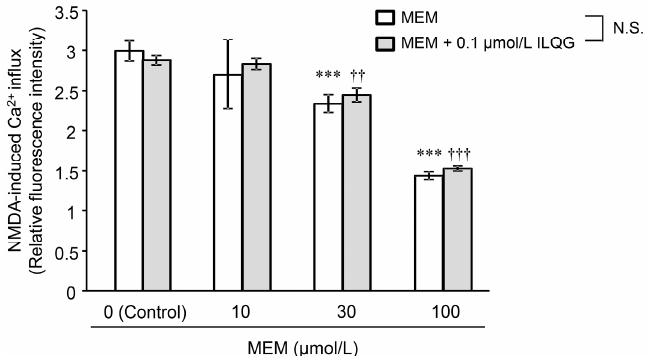
Figure 3. Inhibitory effects of MEM, isoliquiritigenin (ILQG), and their combination on NMDA-induced Ca 2+ influx in primary cultured neurons. A 3-min, NMDA-induced Ca 2+ influx reaction was started by adding recording buffer containing NMDA (final concentration of 300 µ mol/L) or NNDA + test substance (final concentration of 10–100 µ mol/L MEM, 0.1 µ mol/L ILQG, or a mixture) to cultured cells treated with loading buffer, including Fluo 4-AM (5 µ mol/L) at 37 ◦ C for 60 min. Fluorescence intensities of Fluo 4 were measured before (pre-value) and 3 min after the addition of the recording buffer using a plate reader. The Ca 2+ influx data for 3 min are expressed as relative fluorescence intensity against the pre-value before the addition of the recording buffer including NMDA, and are represented as mean ± standard deviation ( n = 6). *** p < 0.001 versus control (vehicle) in MEM group, and †† p < 0.01 and ††† p < 0.001 versus control (0.1 µ mol/L ILQG) in the MEM + ILQG group (Tukey’s test following two-way ANOVA). N.S.: no statistical significance was observed between MEM